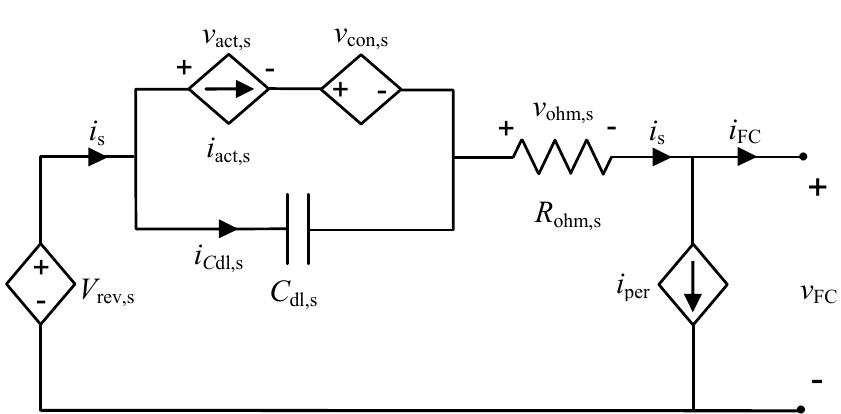
Figure 2. Electrical model of the FC.